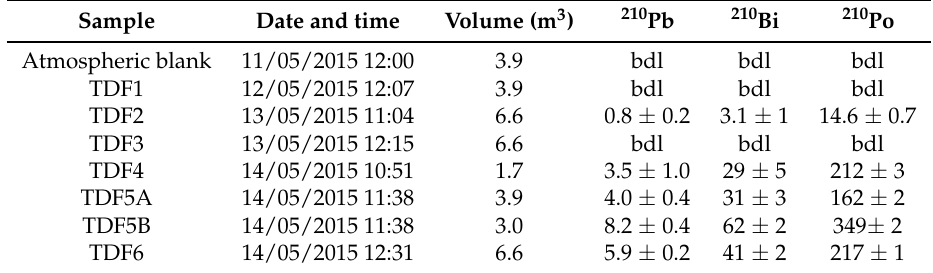
Table 1. 210 Pb- 210 Bi- 210 Po radioactivity in Mount Etna plume. Sample names correspond to sampling sites as described in Figure 2. Activities are reported in mBq/m 3 with 1- σ uncertainties. “bdl” stands for below detection limit. Sampling starting time is expressed in local